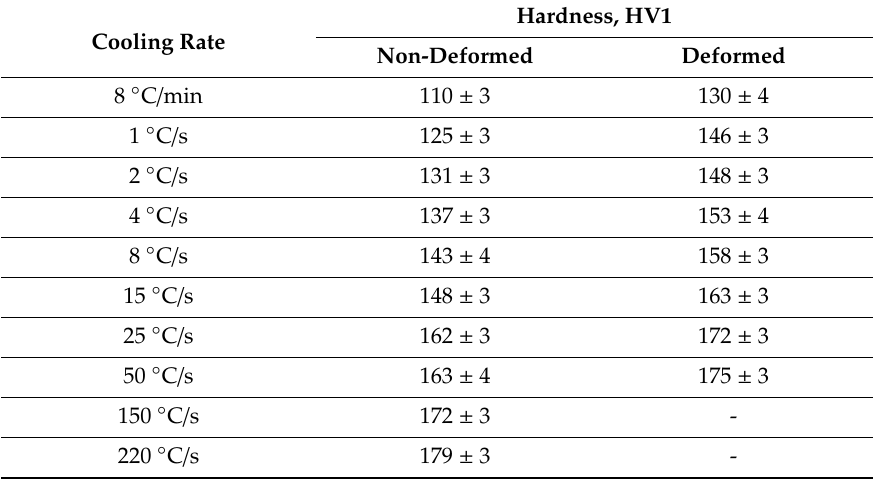
Table 3. Hardness measurements of non-deformed and deformed